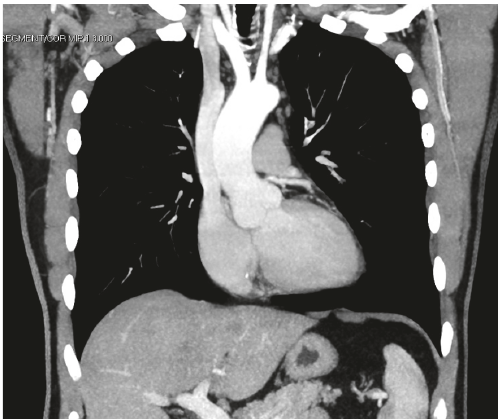
Figure 3: Postoperative contrast CT scan of the thorax demonstrat- ing normal appearance of the right and left sinuses of